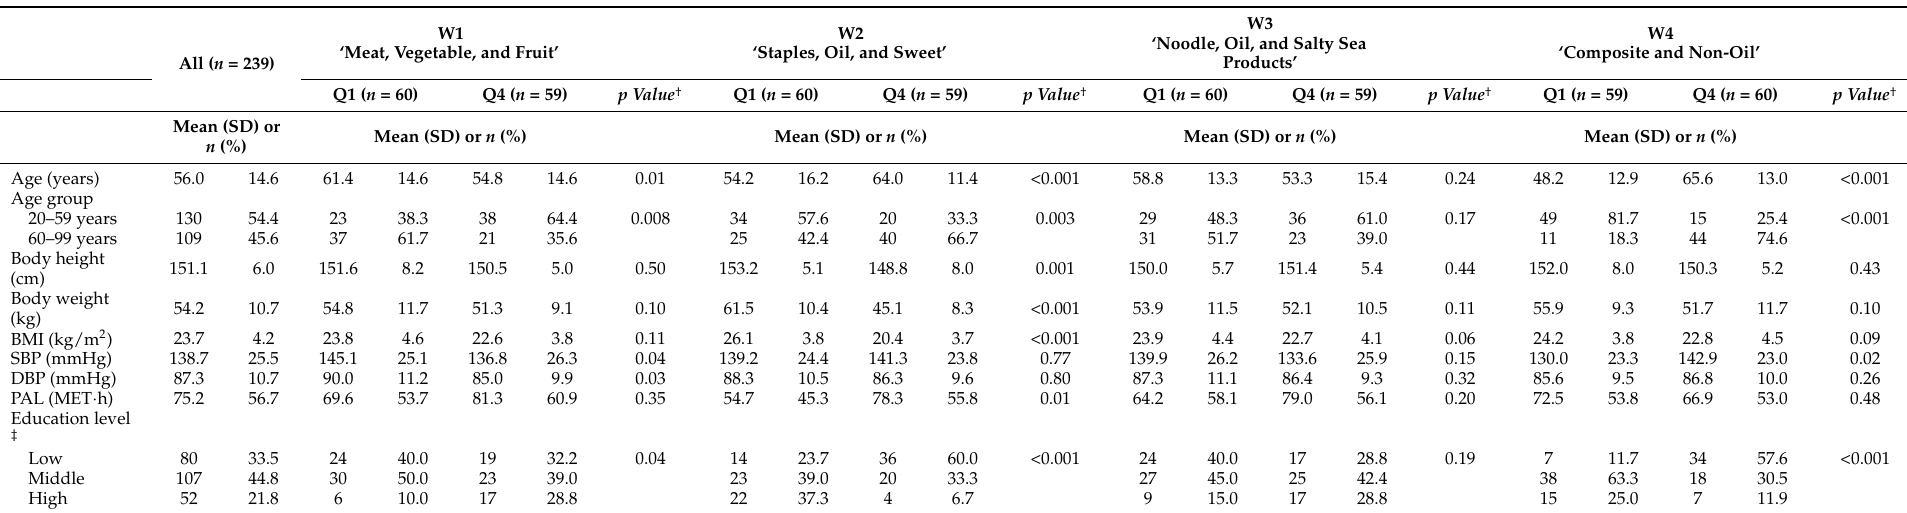
Table 2. Participant’s characteristics for the lowest (Q1) and highest (Q4) for women n = 239